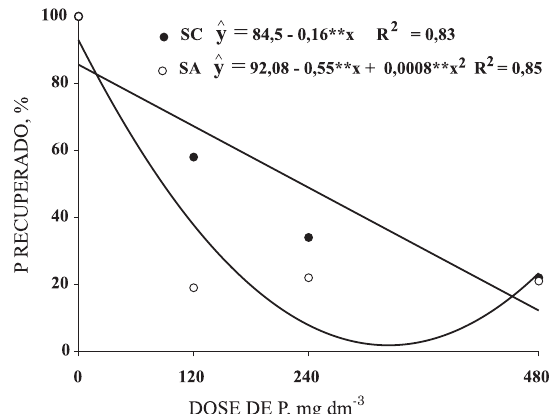
Figura 4. Percentagem de recuperação pelas plantas (feijoeiro + braquiária) do P adicionado em função das doses e do histórico de uso (solo adjacente (SA) e cultivado